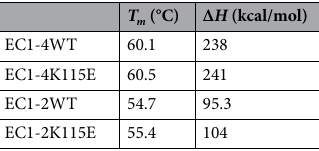
Table 1. Results of differential scanning calorimetry (DSC) measurements.